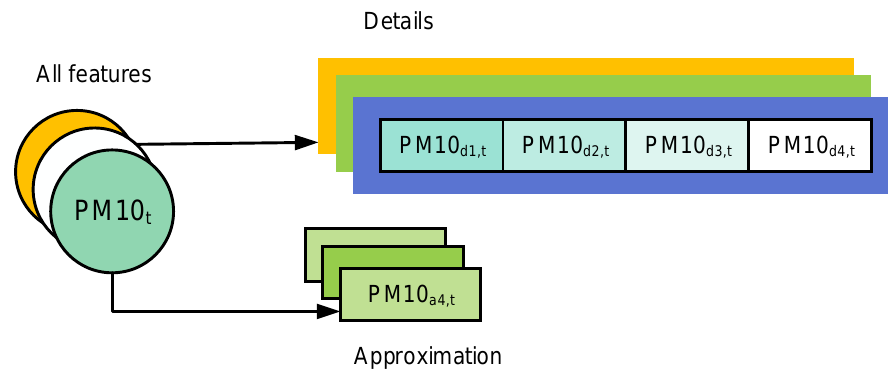
Figure 6. Decomposition of datasets using the DWT.